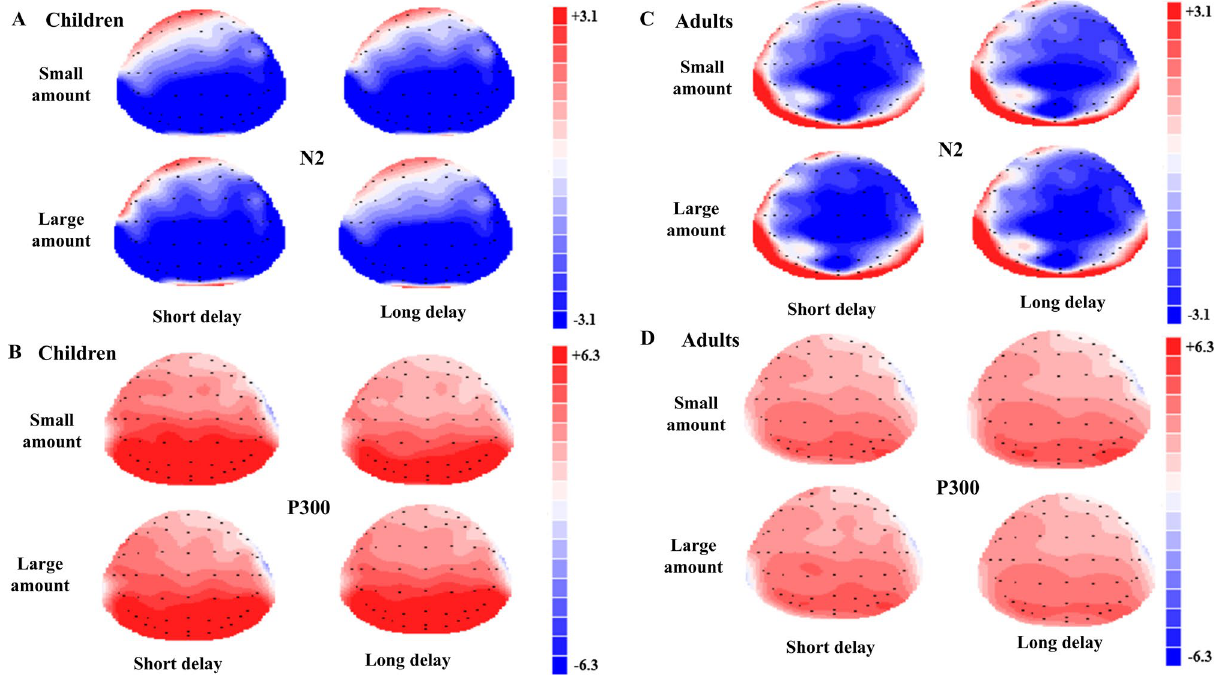
Figure 4. The topographic maps for N2 ( A ) and P3 ( B ) components in children. ( C ) and ( D ) shows the topographic maps for N2 and P3 components in adults. The picture was created by Scan 4.5 (http:// www. neuro scan. com/) and Microsoft PowerPoint 2016 MSO (16.0.13628.20234) 64 bits (https:// www. micro soft. com/ zh- cn/ micro soft- 365/ power For N2 latencies, the interaction effect of age and time delay was marginally significant, F (1, 102) = 3.72, p = 0.06, ƞ 2 = 0.04. It was further found that for children the latencies of long delay were longer than those of short delay (mean short delay = 247.62, mean long delay = 240.78; p = 0.004; ƞ 2 = 0.079). However, for adults, the latencies of short delay were not significantly different from those of long delay (mean short delay = 249.95, mean long delay = 249.69; p = 0.917). The results of N2 response indicated that age effects on N2 amplitudes were mainly affected by reward amount while age effects on N2 latencies were mainly influenced by time delay. For P3 amplitudes, the interaction effect of reward amount, time delay and age was significant, F (1, 102) = 5.07, p = 0.027, ƞ 2 = 0.05. After the simple effect test, in small amount condition, children had larger P3 amplitudes for the short delay conditions than for the long delay conditions (children, small amount: mean short = 5.94, mean long = 4.72, p < 0.001), while in the large amount conditions for children and in small and large amount condi- tions for adults, P3 amplitudes in the short delay conditions were not different from those in the long delay con- ditions (children, large amount: mean short = 5.57, mean long = 5.64, p = 0.84; adults, small amount: mean short = 3.18, mean long = 3.11, p = 0.82; adults, large amount: mean short = 3.19, mean long = 3.01, p = 0.59). In addition, for chil- dren in the long delay conditions, the amplitudes of small amounts were smaller than those of large amounts ( p = 0.002), while for children in the short delay conditions and for adults in the short and long delay conditions, there were no significant differences between the amplitudes of small amounts and large amounts (children, short delay, small amount and large amount: p = 0.25; adults, short delay, small amount and large amount: p = 0.97; adults, long delay, small amount and large amount: p = 0.76). In short word, the P3 amplitudes results showed that children exhibited larger amplitudes in small amount and short delay condition and in large amount and long delay condition compared with small amount and long delay condition while adults showed comparable amplitudes in these conditions. For P3 latencies, the interaction effect of reward amount, age and gender was marginally significant, F (1, 102) = 3.30, p = 0.07, ƞ 2 = 0.03. After a simple effect test, it was found that all comparison pairs except in large amount condition for females were significant (small amount: mean female children = 357.69, mean female adults = 370.92, p = 0.043; mean male children = 354.09, mean male adults = 368.14, p = 0.018; large amount: mean female children = 360.61, mean female adults = 366.76, p = 0.249; mean male children = 353.95, mean male adults = 372.380, p < 0.001). The results indi- cated there were no significant age differences on P3 latencies in large amount condition for females while in other conditions there were significant age differences. For P3 latencies, the interaction effect of time delay, gender and age was also significant, F (1, 102) = 10.90, p = 0.001, ƞ 2 = 0.10. A simple effect test revealed that in short delay condition, the P3 latencies of female children were shorter than those of female adults, the latencies of male children were shorter than those of male adults and in long delay condition, the P3 latencies of male children were shorter than those of male adults (short delay: mean female children = 358.73, mean female adults = 372.82, p = 0.018; mean male children = 354.72, mean male adults = 365.90, p = 0.037; long delay: mean female children = 359.57, mean female adults = 364.86, p = 0.364; mean male children = 353.33,